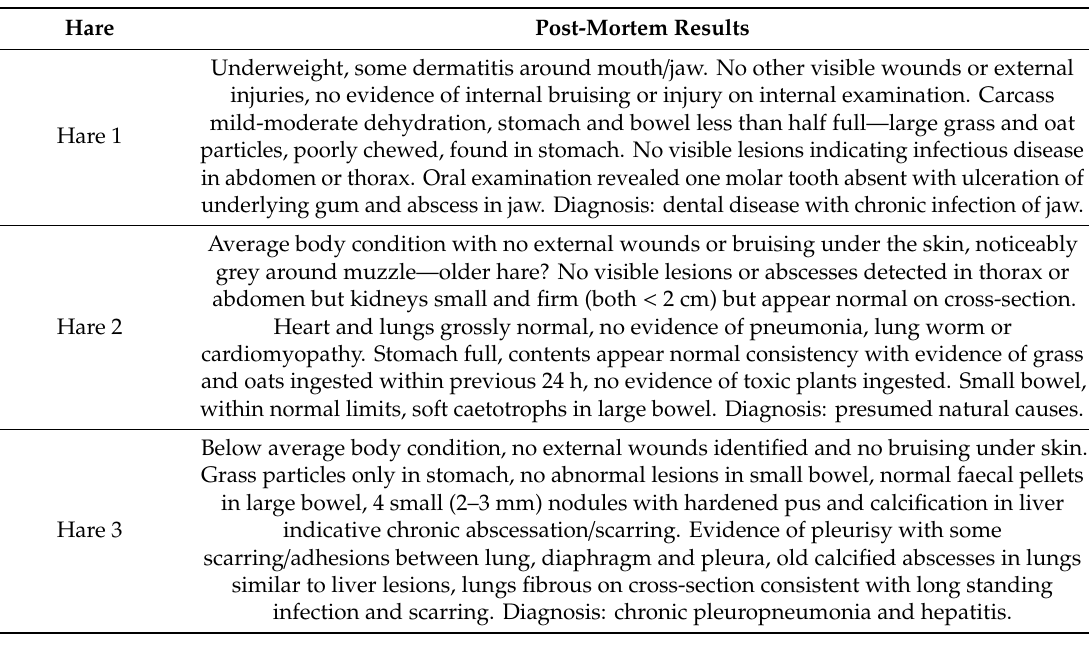
Table 3. Results of post-mortems of three hares found dead by NPWS in hare compound at a coursing club in Edenderry, Co. O ff aly, in